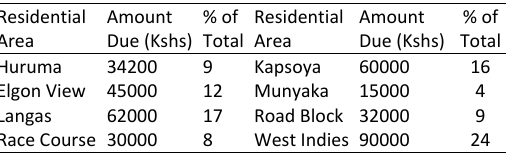
Table 4: “Din” containers withdrawn in 2018 (The Director of Environment and Enforcement, 2018)